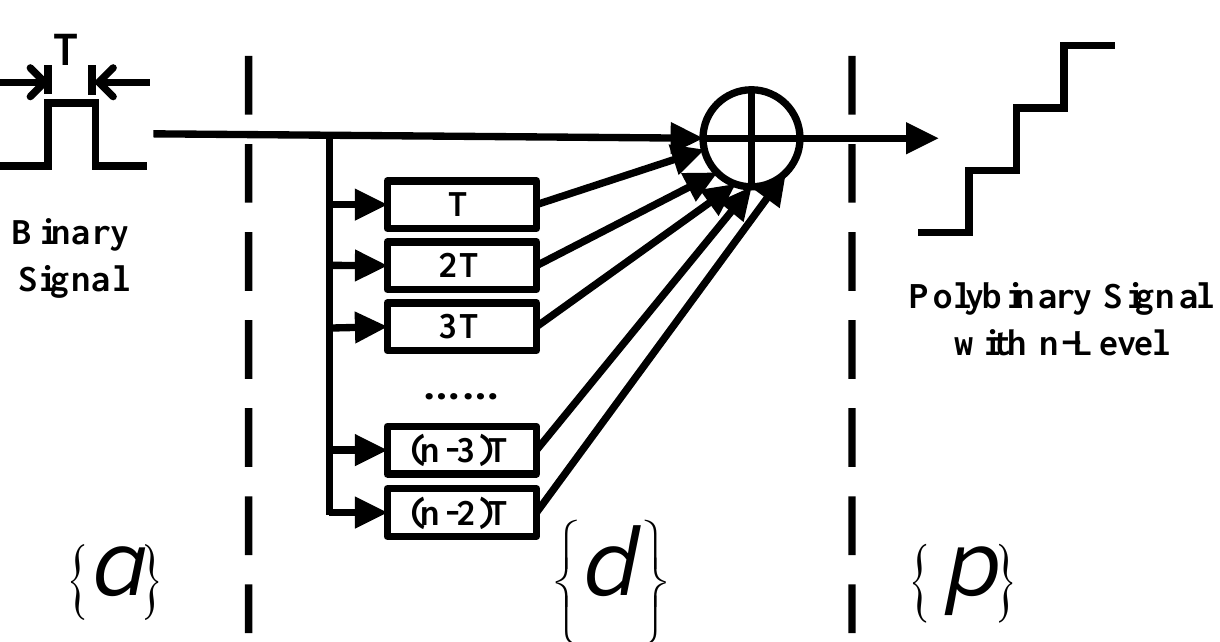
Figure 1. Structure of n-level polybinary signal by delay operations and modulo-two sum operations.